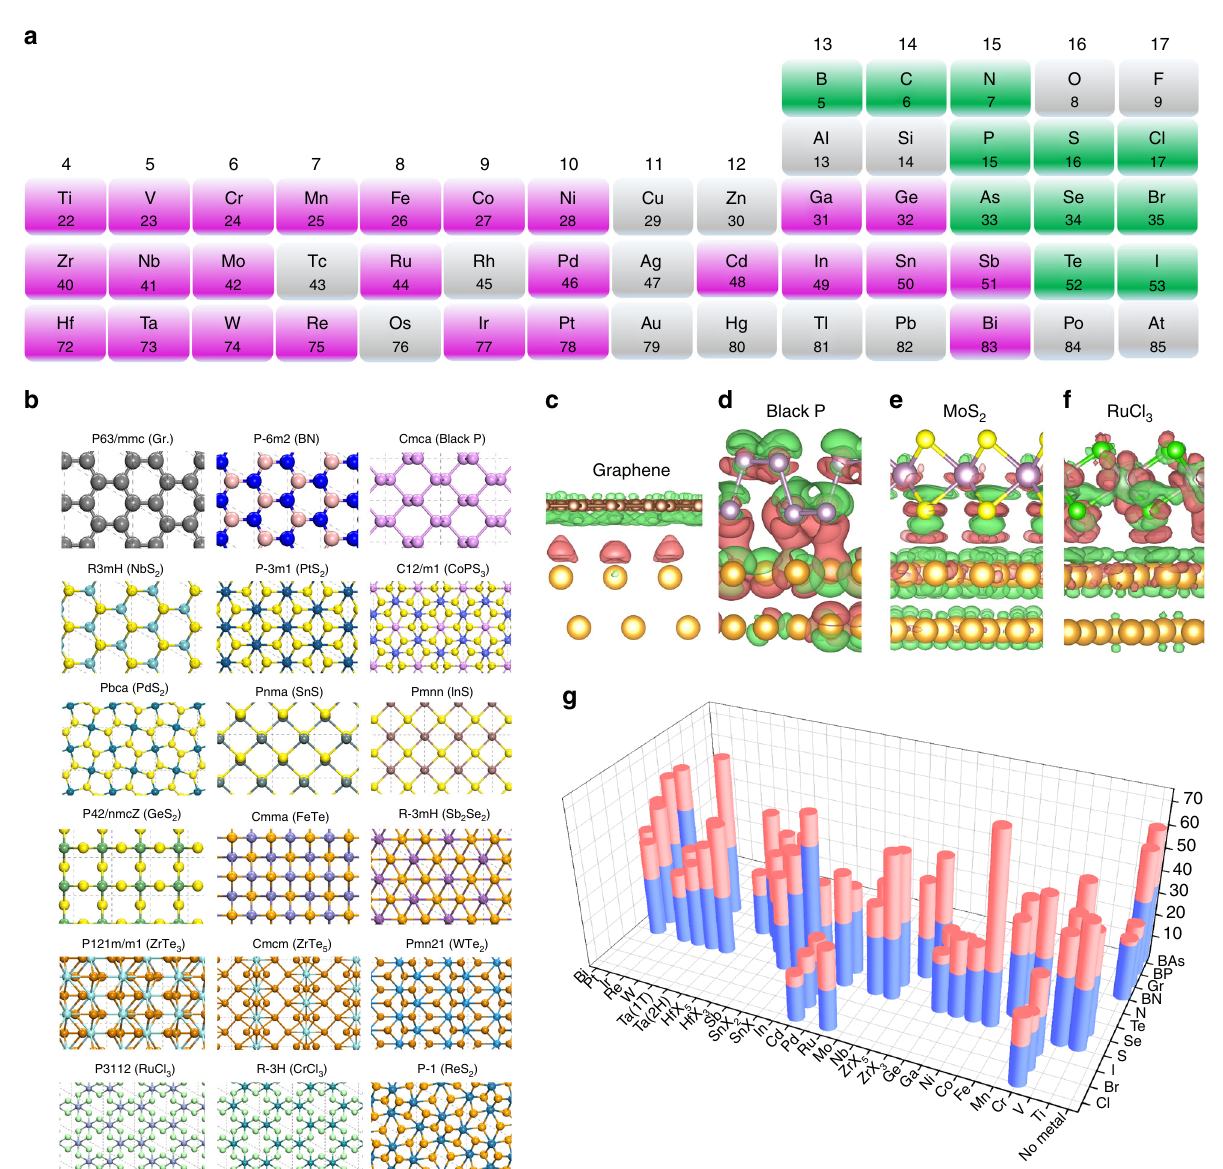
Fig. 1 DFT calculated interlayer binding energies of 2D materials and adsorption energies on Au (111) surfaces. a Part of the periodic table, showing the elements involved in most 2D materials between groups 4 (IVB) and 17 (VIIA). b Eighteen space groups and typical structural con fi gurations (top views) of the 2D materials. c – f DCD of four Au (111)/2D crystal interfaces with (non-metallic) terminating atoms between groups 14 (IVA) and 17 (VIIA). Isosurface values of these DCD plots are 5 × 10 − 4 e Bohr − 3 (graphene), 1 × 10 − 2 e Bohr − 3 (BP), and 1 × 10 − 3 e Bohr − 3 (MoS 2 , RuCl 3 ), respectively. g Bar graph comparing the interlayer binding energies of 2D materials (blue cylinders) with their adsorption energies on Au (111) (red cylinders). The visible red cylinders represent the difference between the Au/2D crystal interaction and the interlayer